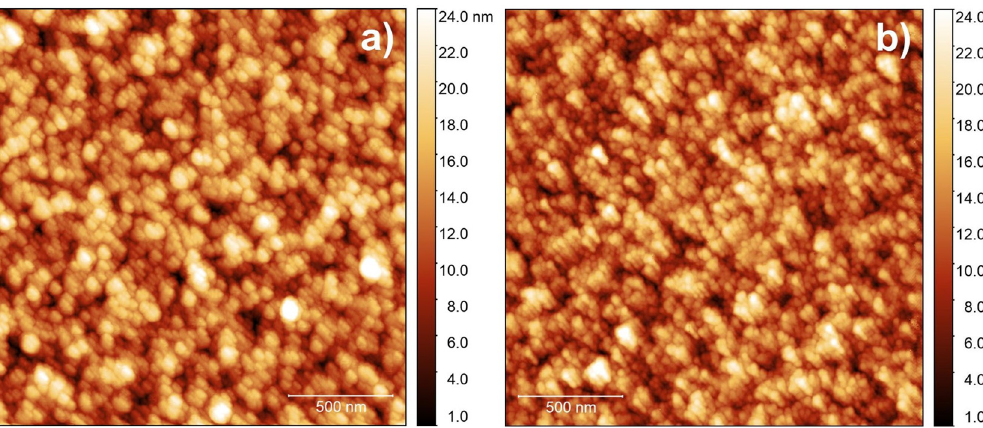
Figure 7. AFM measurement of ( a ) IrO 2 deposited on PtSi and ( b ) PtSi surface morphology. Both images have scan size of 2 µm × 2 µm and image resolution is 512 × 512 points per line. The thickness of IrO 2 is about 14.8 nm.